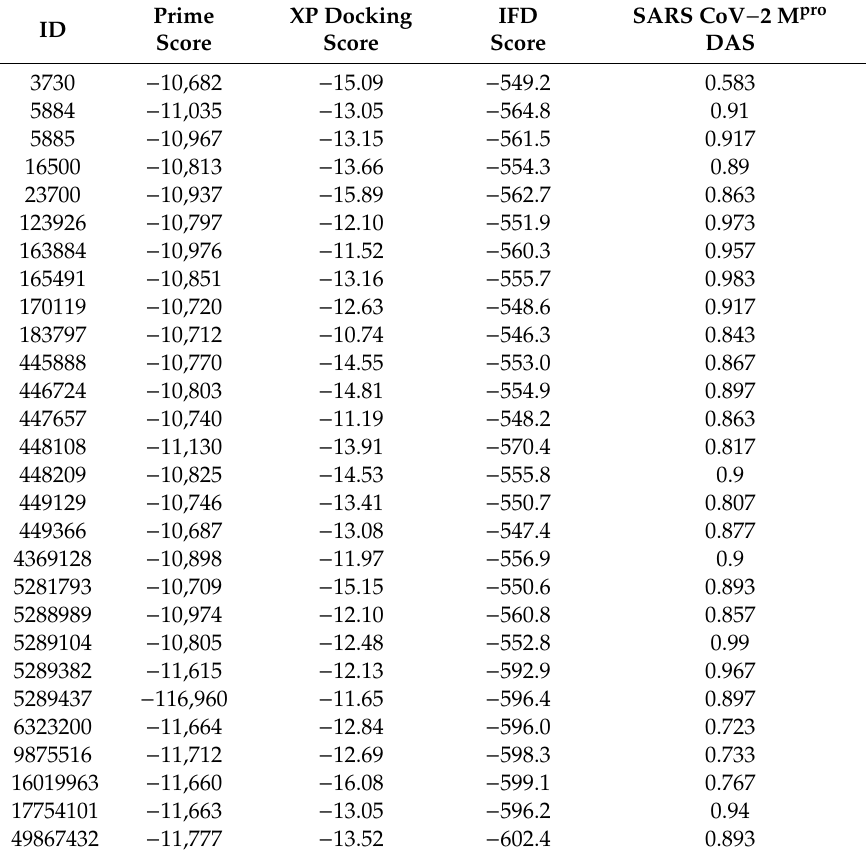
Table 2. IFD and biotarget DRUDIT a ffi nity scores (DAS) for the selected